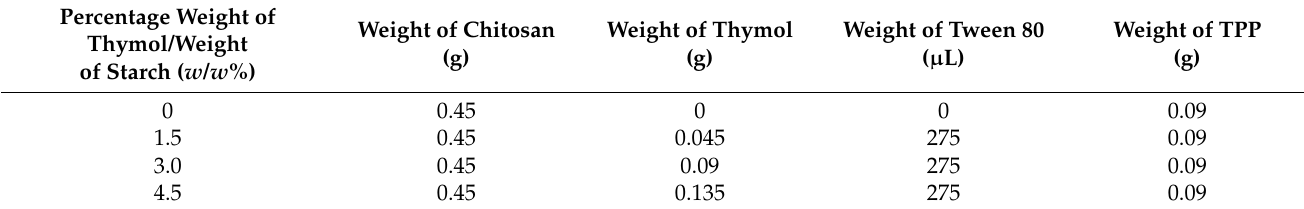
Table 1. Formulation of CS/CNP/Thy bio-nanocomposite film forming